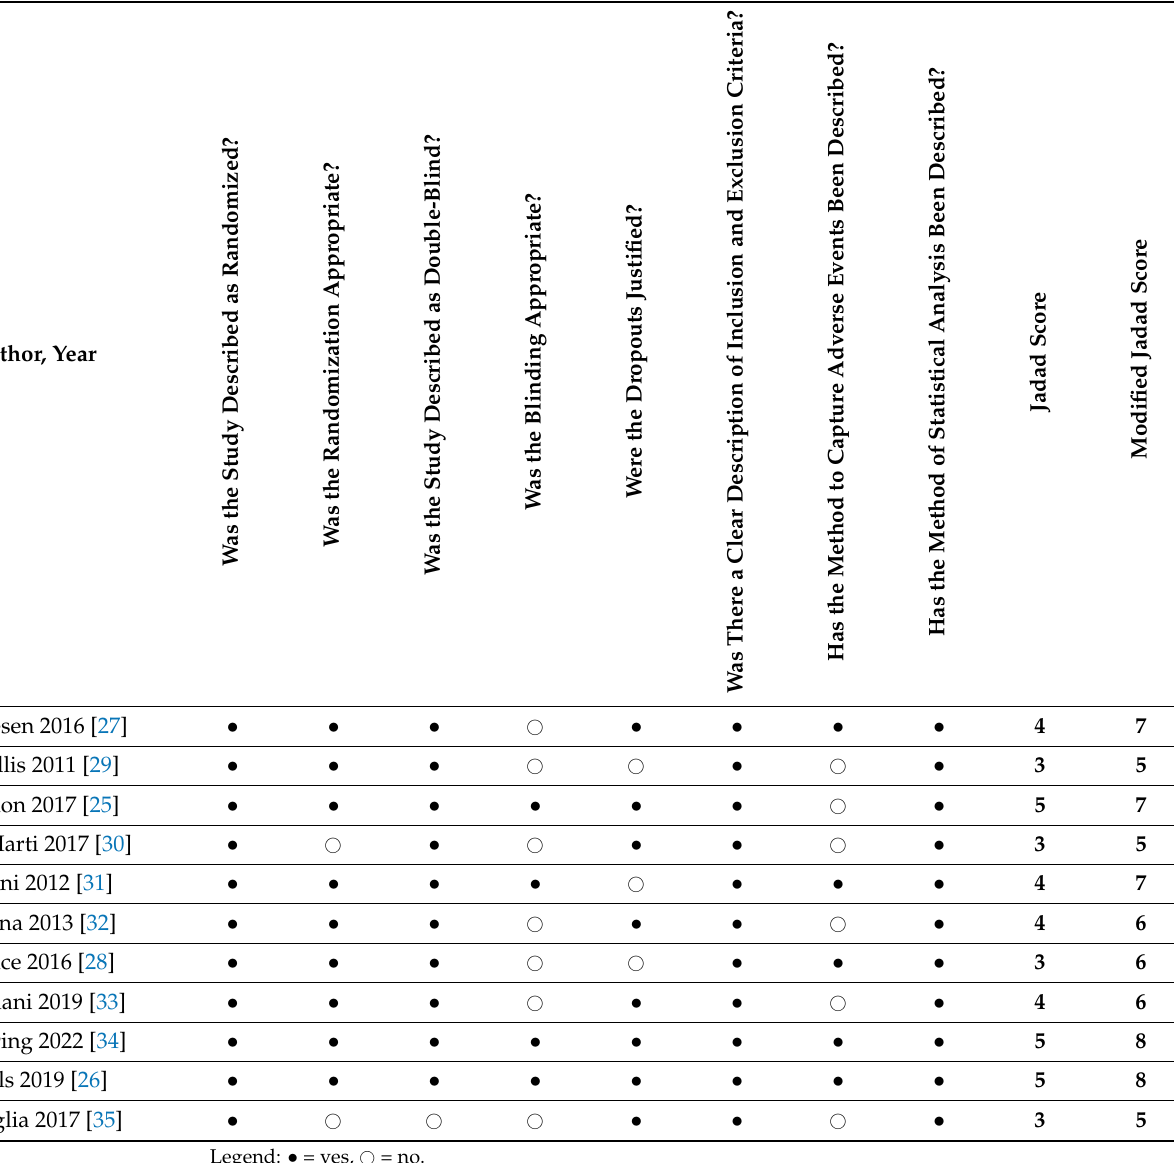
Table 2. Summary of quality assessments for individual articles included in the systematic